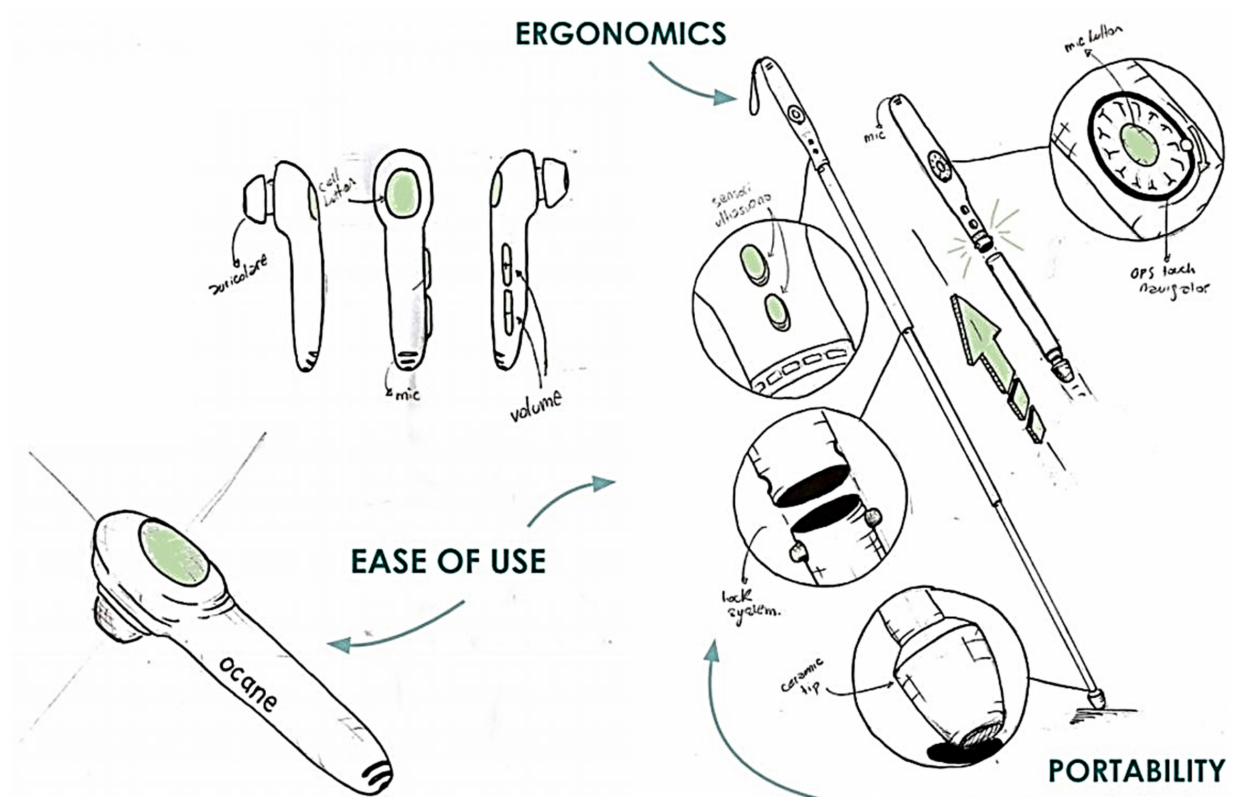
Figure 5. Initial